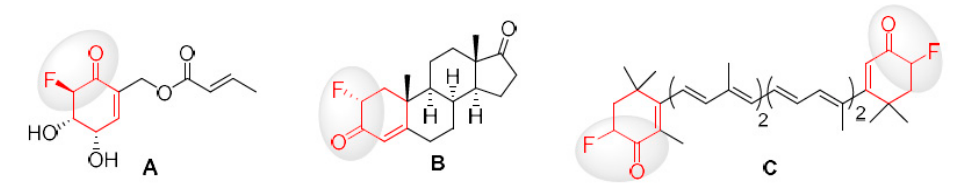
Figure 1. Bio-active fluorinated cyclohexenones.